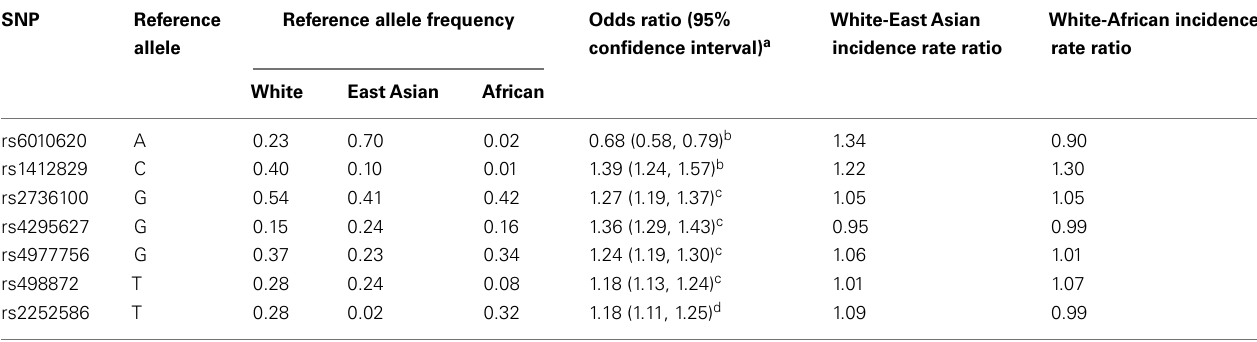
Table 4 | Contribution to ethnic incidence rate ratios by established glioma susceptibility